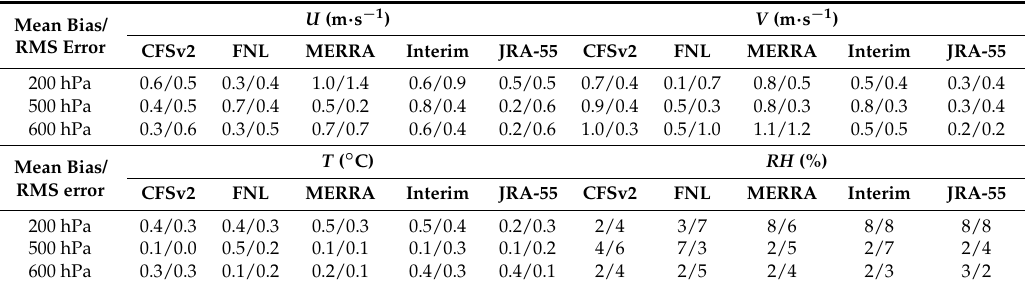
Table 2. The largest difference of mean bias/RMS error in the GDs against the radiosonde data during five years in the TP.